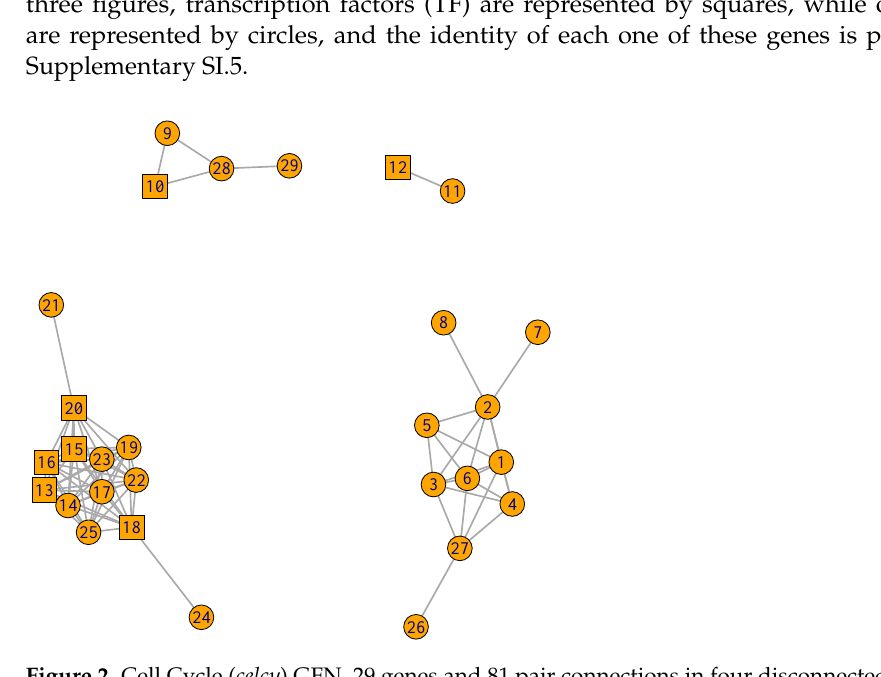
Figure 2. Cell Cycle ( celcy ) GFN. 29 genes and 81 pair connections in four disconnected sub-graphs. TF represented by squares, while other genes are represented by circles (Supplementary SI.5 for gene